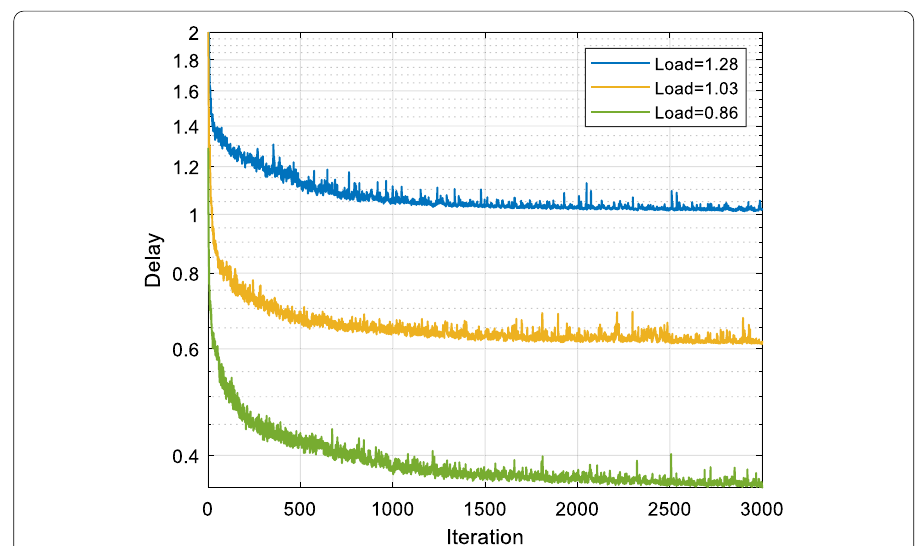
Fig. 7 The delay curves at various loads. The delay performance curves of the RL-based resource allocation scheme with loads of 0.86, 1.03, and 1.28. The x -axis is the number of iterative trainings, and the y -axis is the average delay. The total delay of URLLC data at various loads is decreased by the number of training increases and converges to a certain value after limited